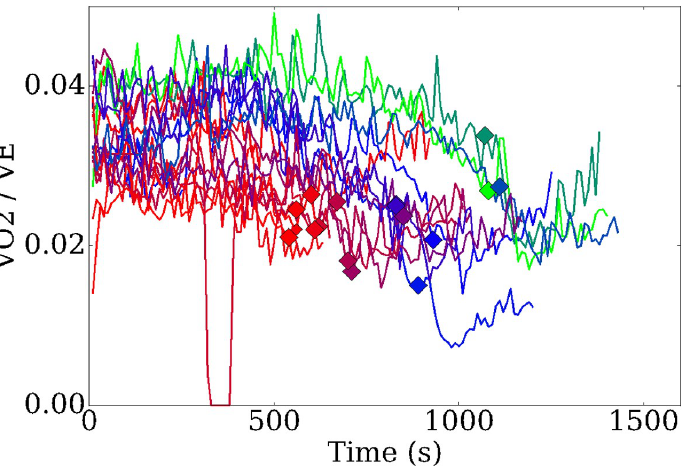
Fig 3. Ratio of oxygen utilisation and total breathing throughout the test. Markers indicate the volitional exhaustion times for each participant.